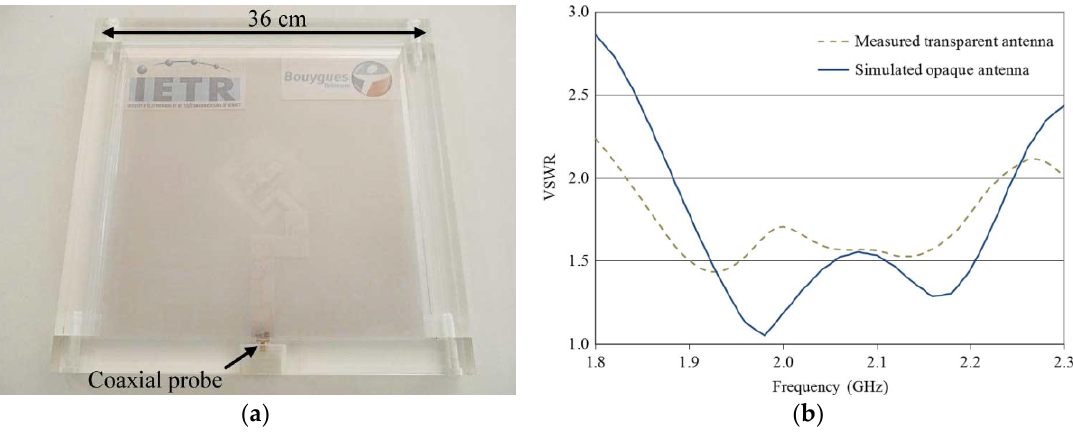
Figure 11. ( a ) Broadband optically transparent H-shaped slot antenna above the lab logo; ( b ) computed and measured VSWR of the broadband H-shaped slot antenna from 1.8 to 2.3 GHz [37]. (With permission from IEEE)